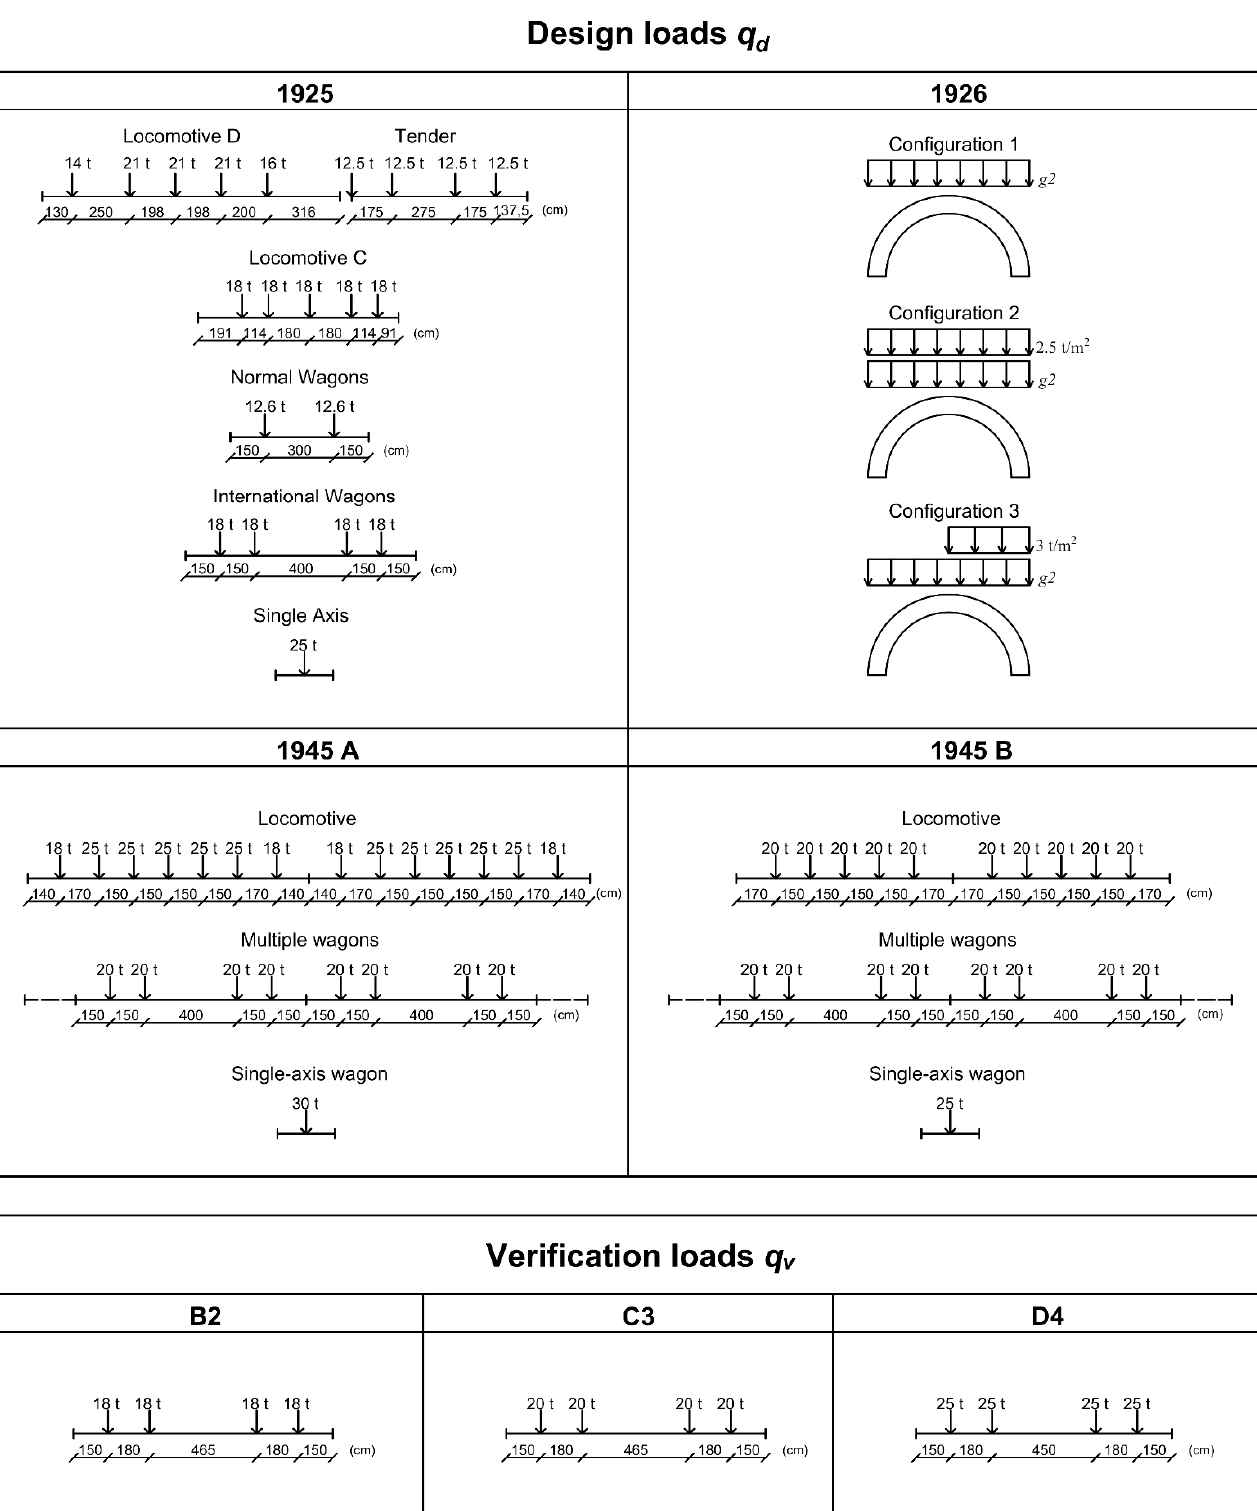
Figure 8. Design and verification loads used for parametric analysis (load weights in tons or tons per square meter).